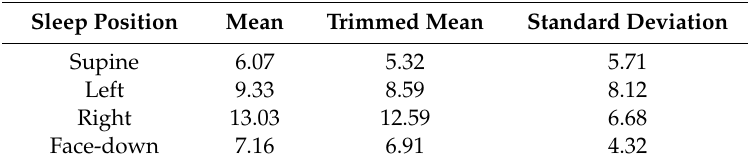
Table 5. Descriptive statistics for respiration peak heights for each sleep position. Peak height data measured in mV.